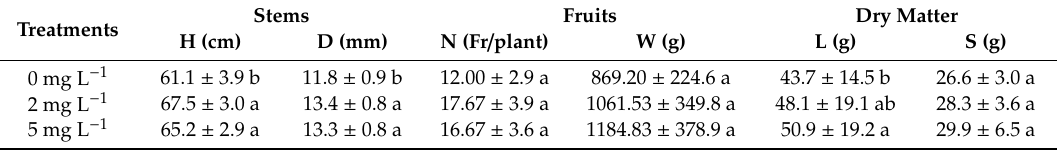
Table 1. Agronomic values from tomato under di ff erent sodium selenite